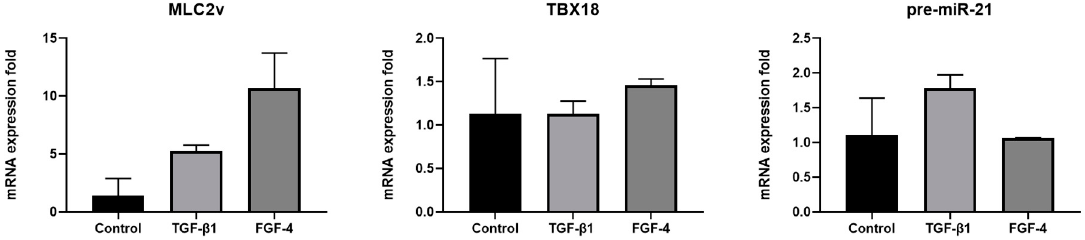
Figure 7. Expression of the cardiomyocyte maturation factors in FGF-4 and TGF- β 1 treated hydrogel samples. Note that the error bars are estimated by the standard deviation of three samples.